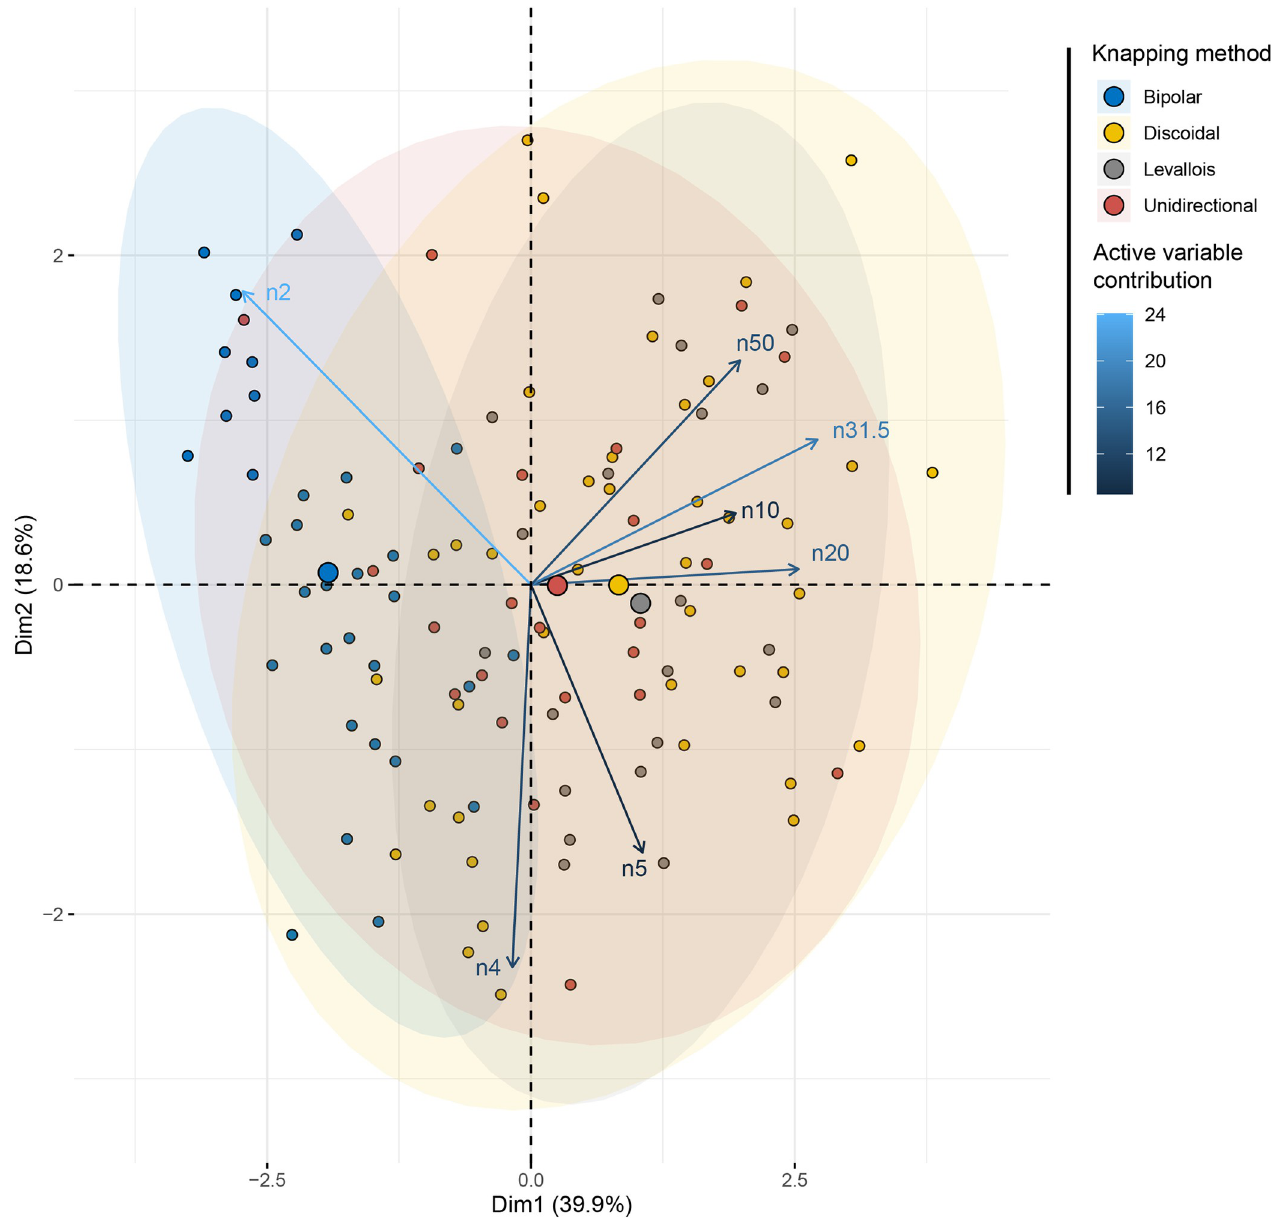
Fig 11. PCA of the SA dataset with the knapping method as a supplementary variable.